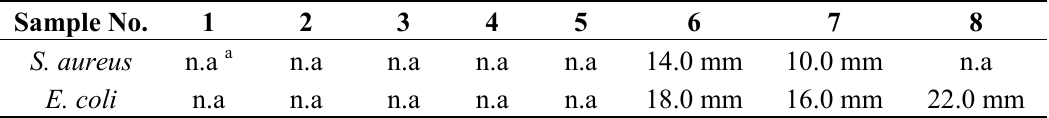
Table 3. Bacteriostatic performance of various substrates against two model bacteria represented by inhibition zone diameter (experimental percentage error is around